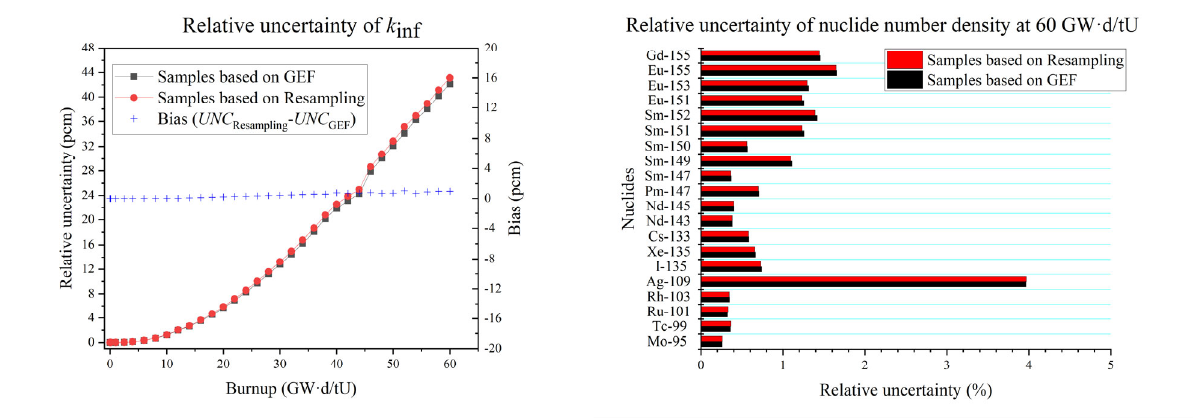
Fig.4. Comparison of uncertainties of the TMI-1 problem based on fission yield samples of 241 Pu+n th .